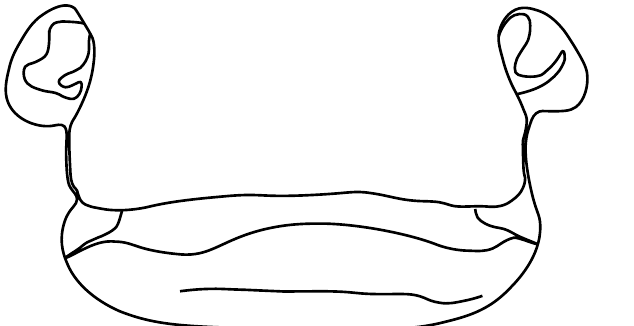
Figure 3. State (0): Interpretative drawings of dorsal mouth and nostrils of Trygonorrhina fasciata taken from (https://fishesofaustralia.net.au/home/genus/1555 (accessed on 10 February